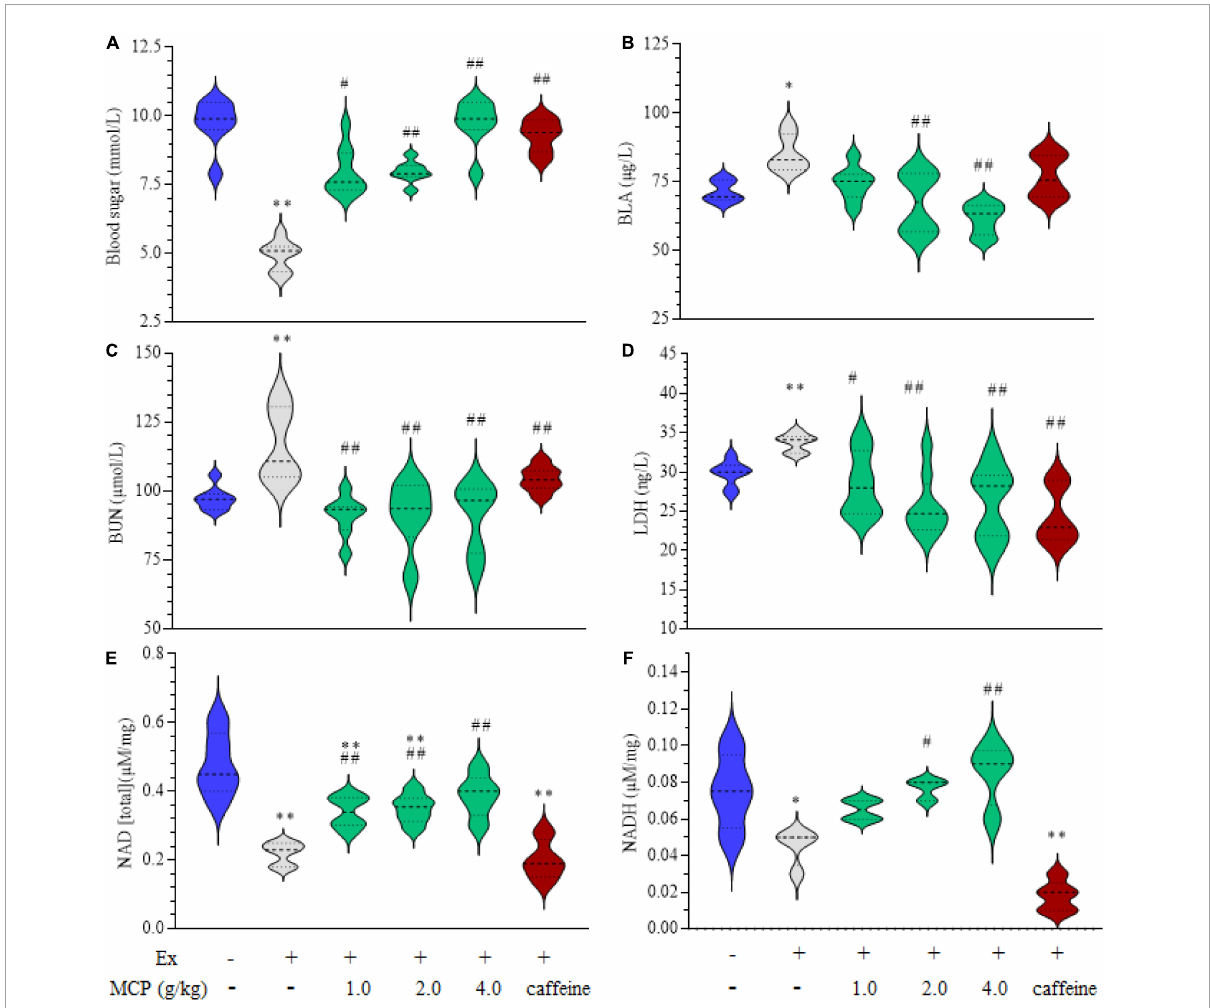
FIGURE2 Effects of Maca compound preparation (MCP) on energetic metabolism of exercise mice. (A) Blood sugar. (B) Blood lactic acid (BLA). (C) Blood urea nitrogen (BUN). (D) Lactate dehydrogenase activity (LDH) in the serum. (E,F) Nicotinamide adenine dinucleotide (reduced) [NAD(H)] in the muscle. ∗ p < 0.05, ∗∗ p < 0.01 vs control (Con); # p < 0.05, ## p < 0.01 vs exercise (Ex)